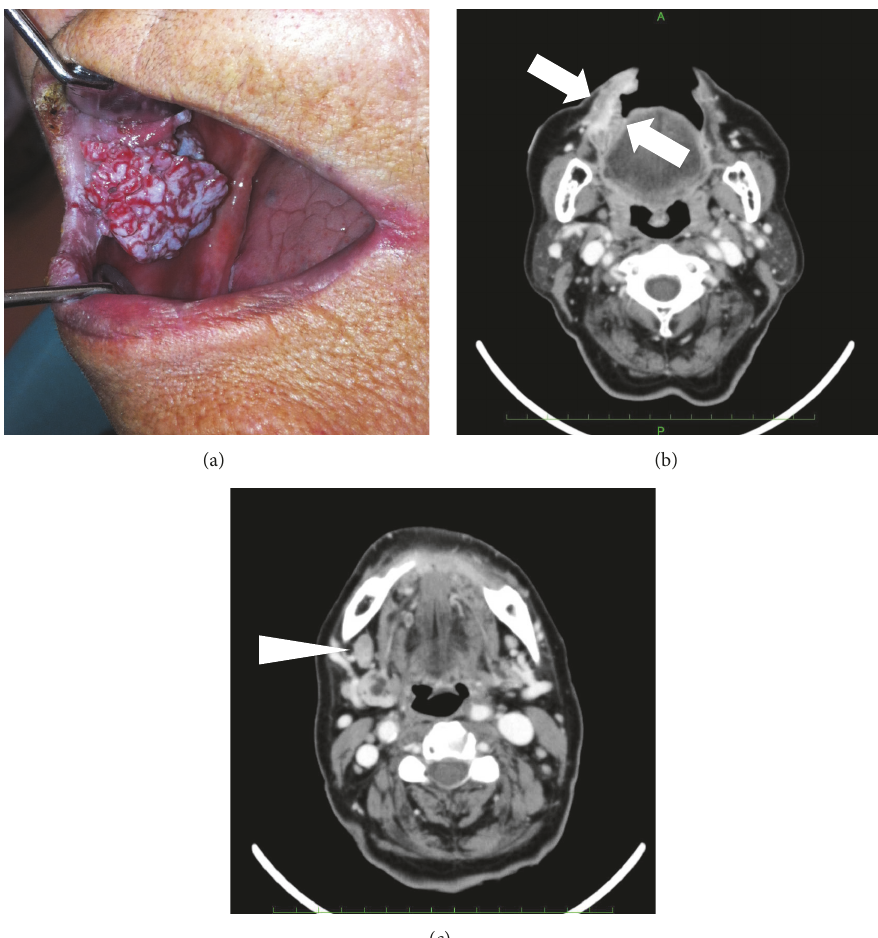
Figure 1: Intraoral findings at initial presentation . Ulcerated lesion in the right buccal area (a). CT images in the right buccal area show an enhanced lesion ((b), arrow) and enlarged submandibular lymph node ((c), arrow